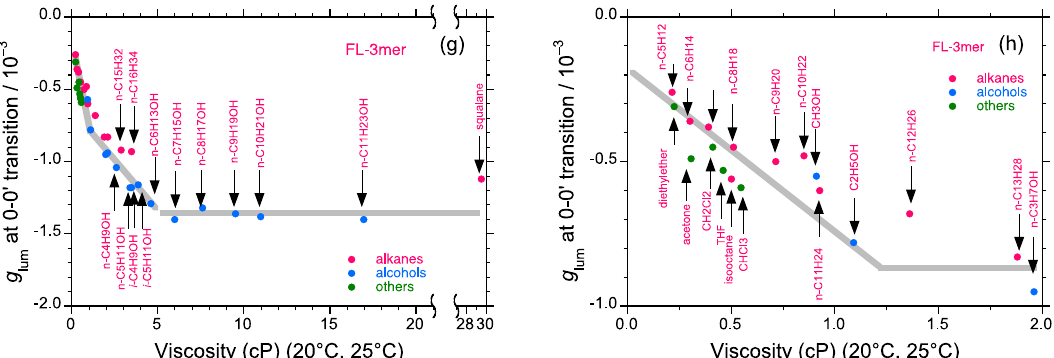
Figure 9. CPL/PL spectra of FL3-C 6 (fluorene trimer) excited at 330 nm at room temperature; ( g ) the g lum value at the 0-0’ band of FL3-C 6 as a function of viscosity (in cP at 20–25 °C) of various achiral alkanes, alkanols and other solvents and ( h ) magnification of the viscosity region 0–2.0 cP . Path length: 10 mm, cylindrical cuvette, conc.: 2 × 10 − 5